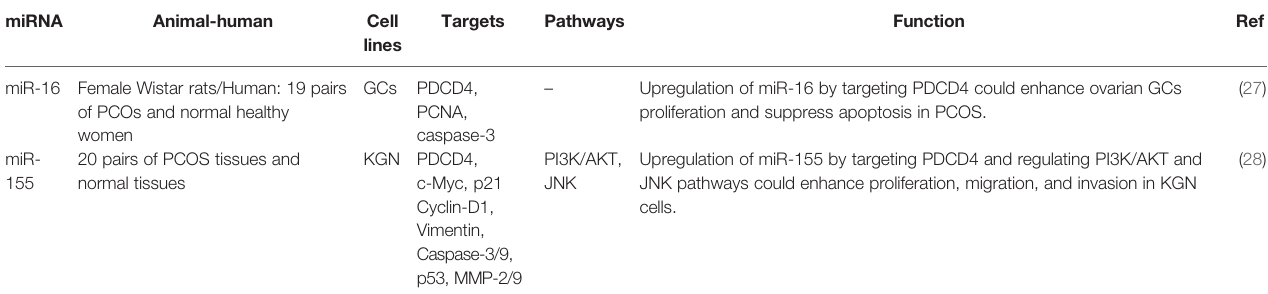
TABLE 2 | Interaction between miRNAs and PDCD in polycystic ovary syndrome (PCOS). miRNA Animal-human Cell Targets Pathways lines miR-16 Female Wistar rats/Human: 19 pairs of PCOs and normal